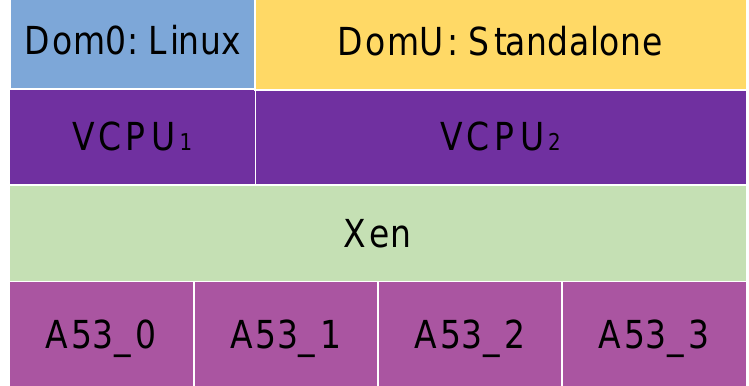
Figure 6. Scenario 6: Xen Linux Dom0 + standalone DomU.